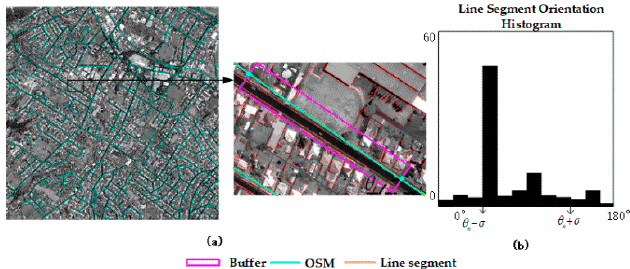
Figure 2. Local road direction determination: ( a ) the overlay of OSM data and the line segment extraction results with the image and a locally enlarged image; ( b ) the LSOH